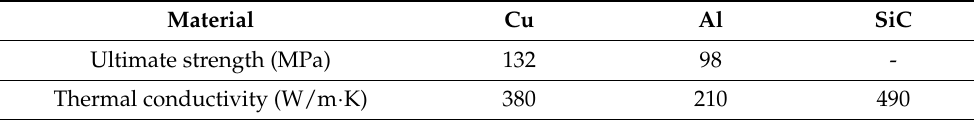
Table 1. The ultimate strength and thermal conductivity of the sheets used in this work. Material Cu Al SiC Ultimate strength (MPa) 132 98 - Thermal conductivity (W/m · K) 380 210